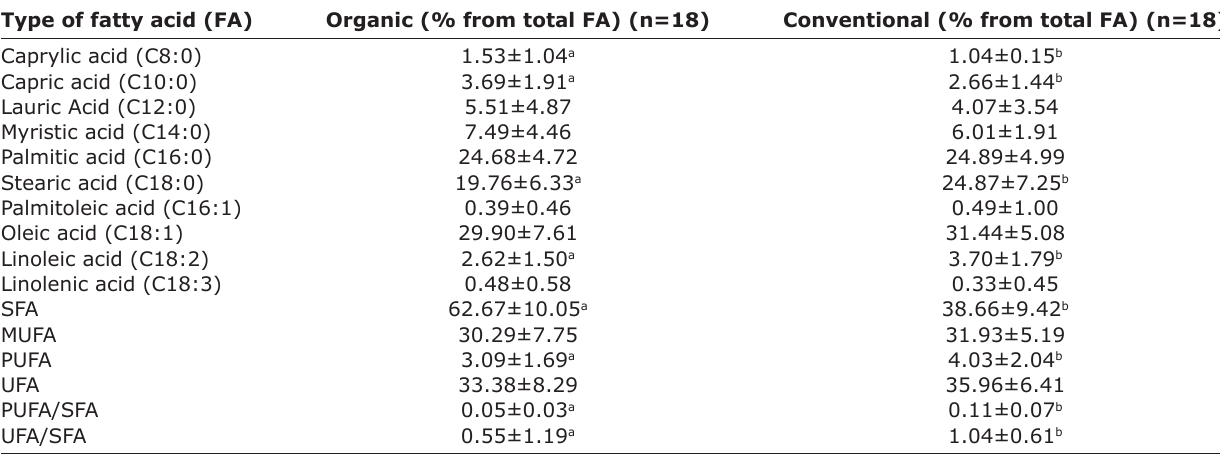
Table-2: Composition of fatty acid in organic and conventional goat milk (mean±SD). Type of fatty acid